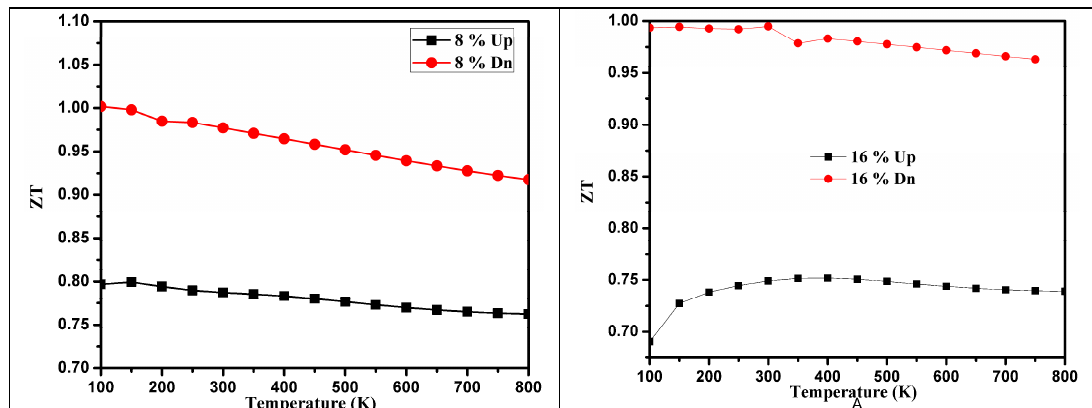
Figure 15. Temperature dependence Figure of merit (long solid curve ‐ black color for up) and (long solid curve ‐ red color for down) for Mn x Zn 1 − x Te (x = 8% and 16%).